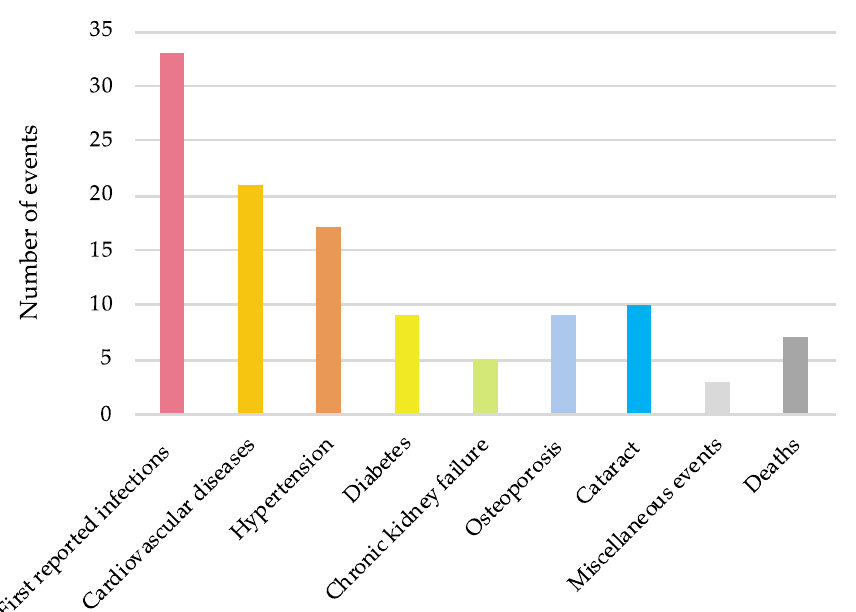
Figure 2. Repartition of the subgroups of the 114 severe outcomes recorded in the 77 patients with giant cell arteritis after a prolonged follow-up. Cardiovascular diseases combine stroke, myocardial infarction, acute heart failure, aneurysm, and peripheral arterial disease. For hypertension and diabetes, new-onset or worsening of previous corresponding conditions are reported. Miscellaneous